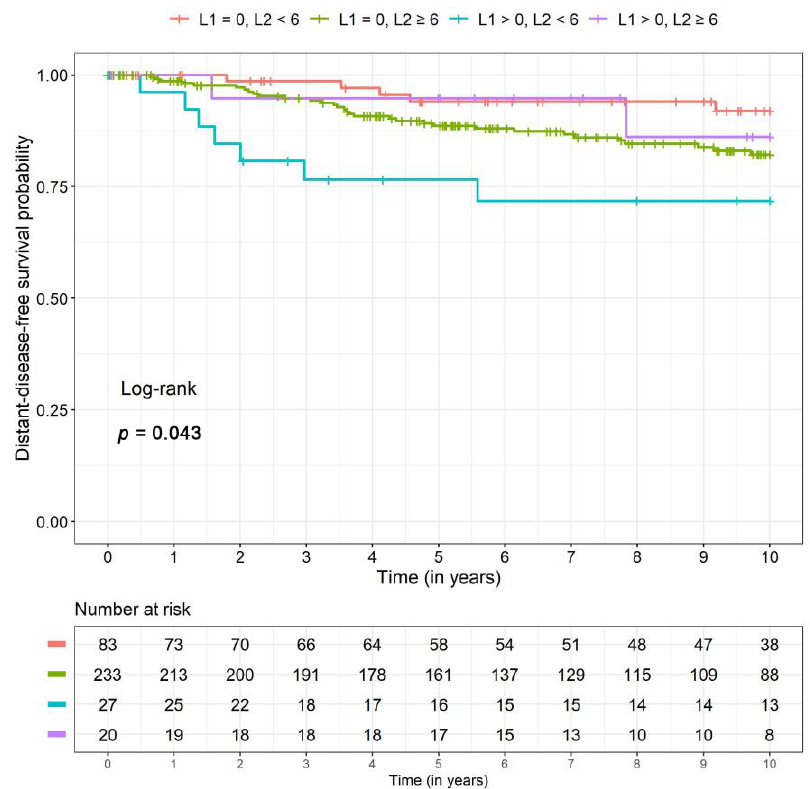
Figure 4. Kaplan–Meier curves for the four di ff erent combinations of PIWI-like 1 IRS (L1) and PIWI-like Figure 5. Kaplan–Meier curves for the four different combinations of PIWI-like 1 IRS (L1) and PIWI- Cancers 2020 , 12 , 2 IRS (L2) for disease-free survival. like 2 IRS (L2) for disease-free survival.